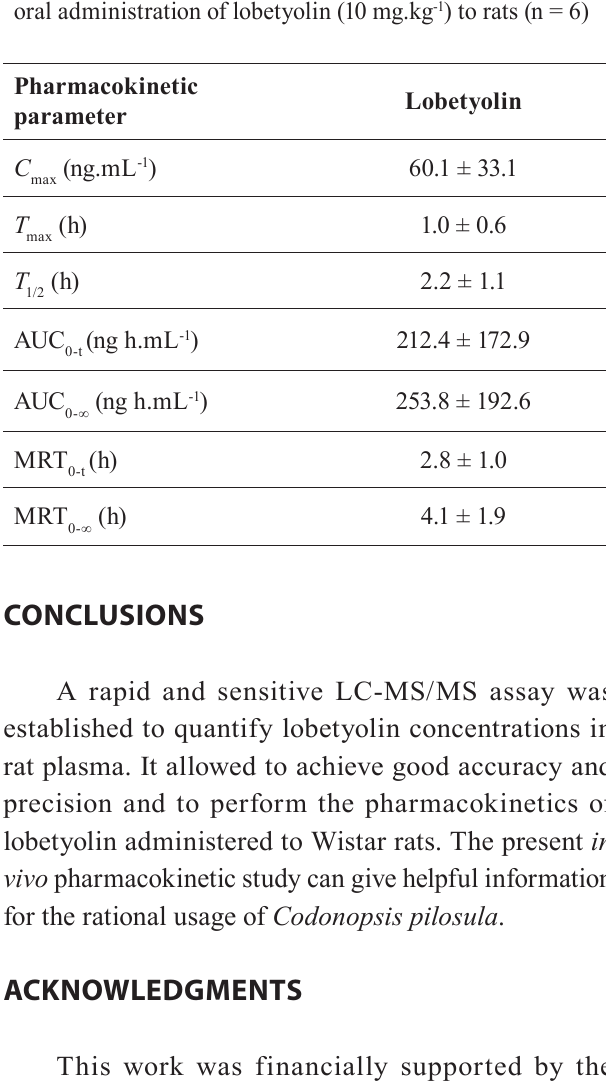
TABLE III - Pharmacokinetic parameters of lobetyolin after an oral administration of lobetyolin (10 mg.kg -1 ) to rats (n =